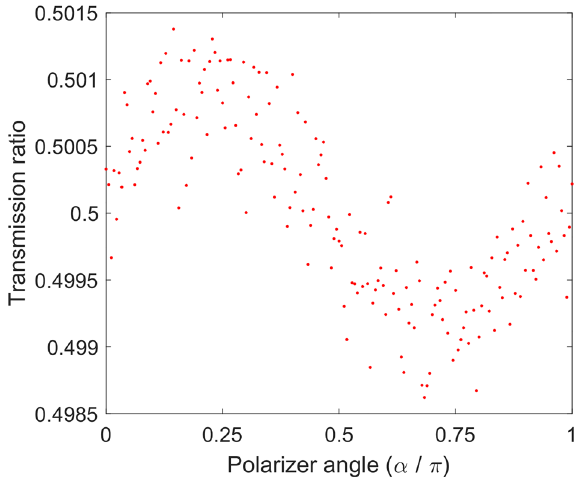
Figure 3. Symmetry condition satisfied by the presented polarizer model. The figure shows that in the proposed model, if N photons which their polarization distribution varies uniformly between 0 to 2π hit the polarizer, almost half of them will pass, independent of the polarizer angle setting. By increasing N this value tends to 0.5. In this example N = 1,000,000 and polarizer angle varies linearly between 0 to 2π. Every dot representing transmission ratio of passed photons in that angle.